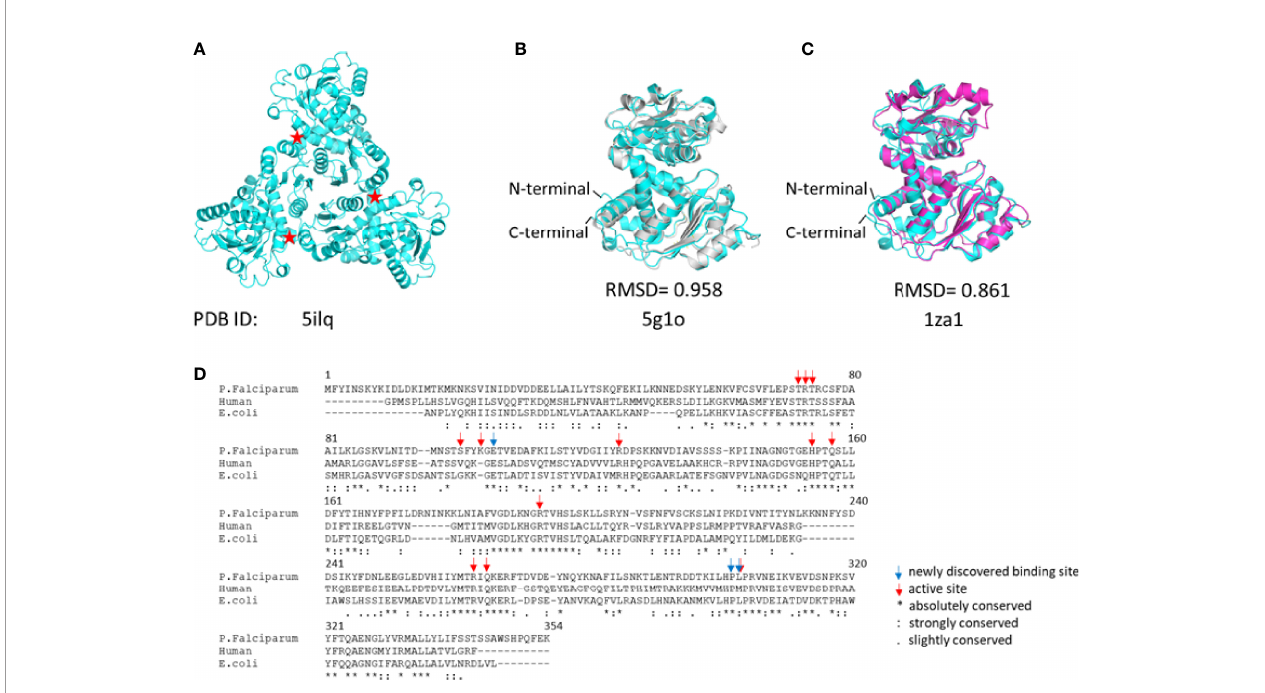
FIGURE 3 | The structure of Pf ATCase compare to hu ATCase and catalytic subunit of E.coli ATCase. (A) A ribbon diagram of the crystal structure of the truncated Pf ATCase indicating an overall trimeric assembly (Lunev et al., 2016), three active sites formed at the oligomeric interfaces are labeled with stars. (B) structural alignment of the monomeric Pf ATCase structure (blue, PDB code: 5ILQ) with human ATCase (grey, PDB code: 5G1O) and the catalytic chain of E.coli ATCase (magenta, PDB code: 1ZA1) (C) . The structural alignments were carried out with Pymol (Schrödinger and DeLano, 2020). (D) multiple protein sequence alignment of the human, P. falciparum and E. coli ATCases using Tcoffee (Armougom et al., 2006; Di Tommaso et al.,